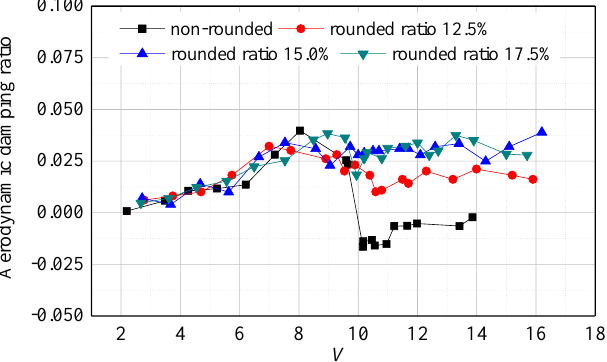
Figure 15. Aerodynamic damping ratio of the aeroelastic model with different rounded ratios. The above analysis indicates that the rounded corner not only reduces the wind load but also improves the aeroelastic effect significantly. Generally speaking, when the rounded ratio reaches 15%, the crosswind vibration of super high-rise buildings can be effectively suppressed.